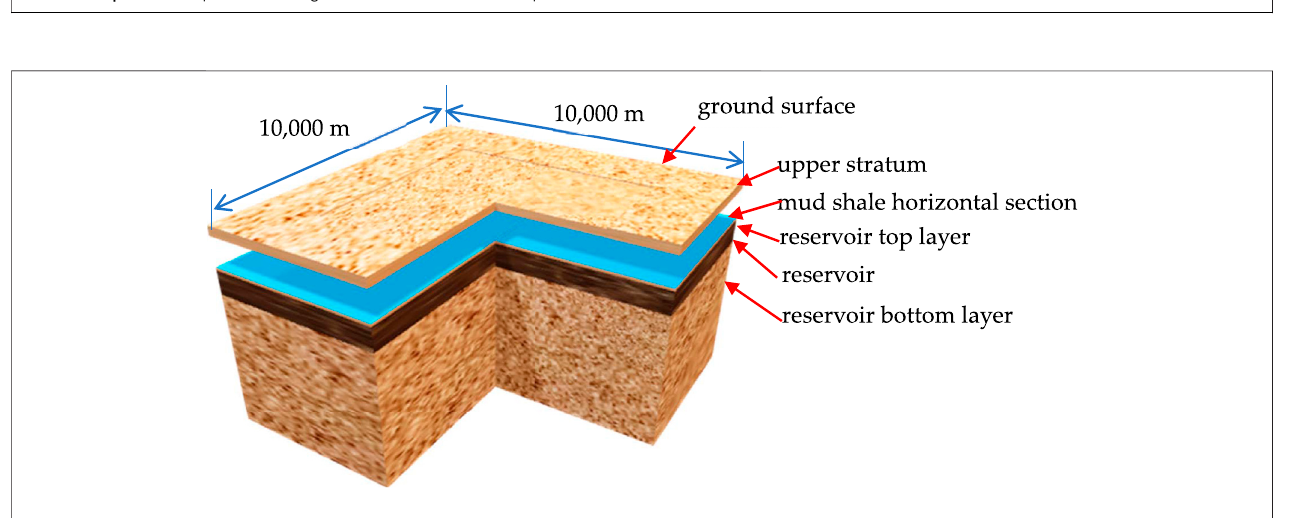
interface continuous vertical displacement and discontinuous horizontal displacement), a reservoir top layer